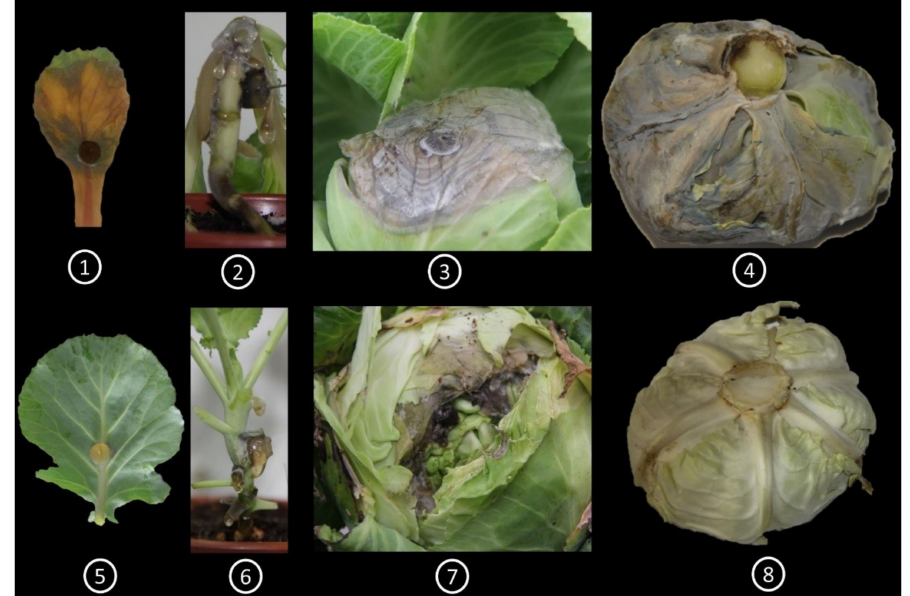
Figure 1. Leaf, stem and head bioassay of the susceptible line SCNU-C-033 ( 1 , leaf; 2 , stem; 3 , head seen from top; 4 , head seen from bottom) and resistant line SCNU-C-049 ( 5 , leaf; 6 , stem; 7 , head seen from top; 8 , head seen from bottom) of cabbage inoculated with S. sclerotiorum . Photographs were taken on the following days post inoculation (DPI): leaf, 5 DPI; stem, 7 DPI; head from top, 10 DPI; head from bottom, 15